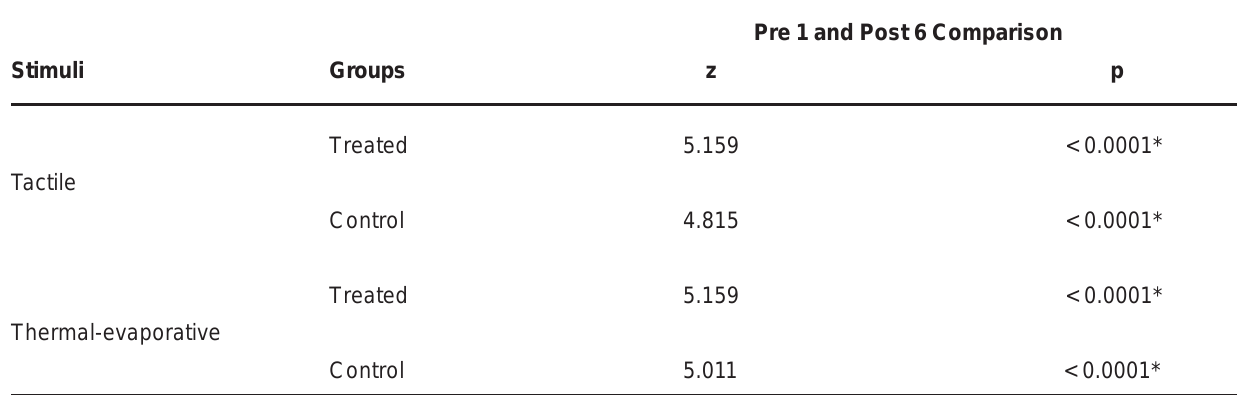
TABLE 1- Comparison between the mean painful sensation between the beginning and end of treatment for both treated and control groups